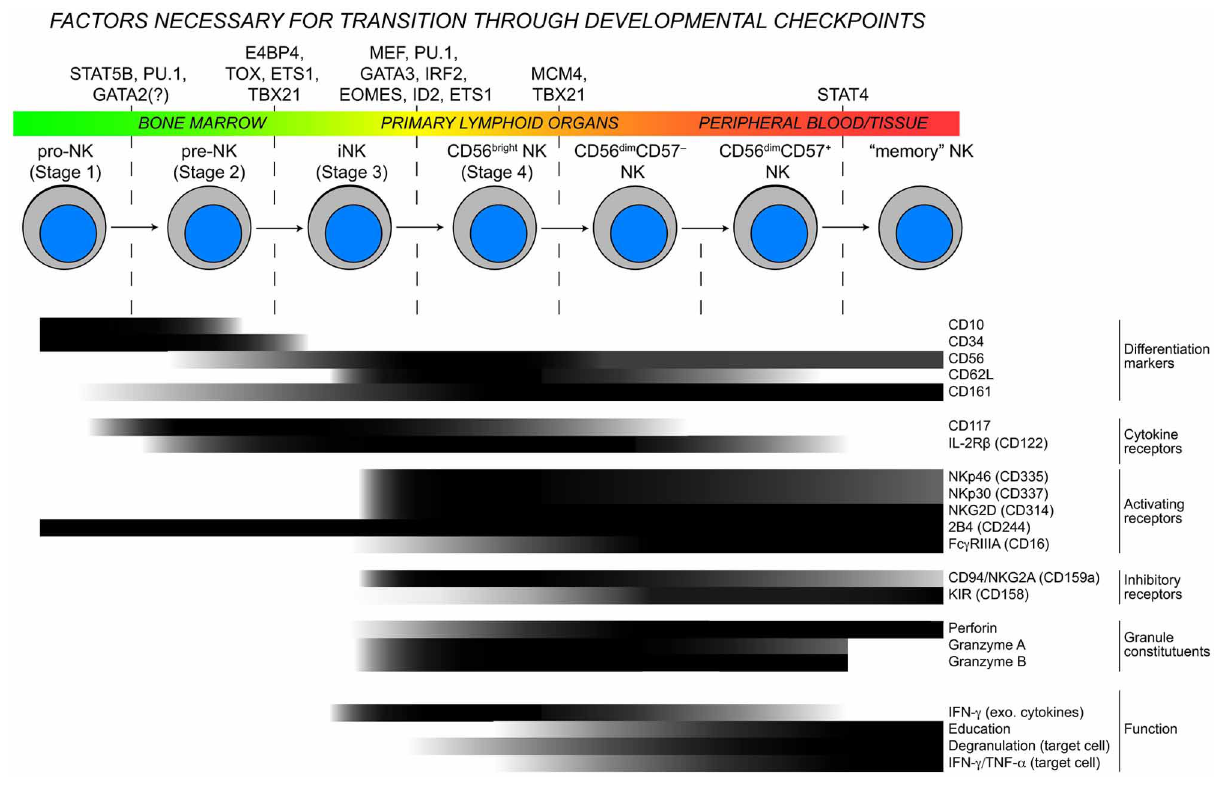
and functional competencies are all dynamically regulated resulting in considerable heterogeneity within the NK cell population. Protein expression data are modified from (Freud et al., 2005; Freud and Caligiuri, 2006) and for “memory” NK cells extrapolated from (Sun et al., 2009; Hwang et al.,